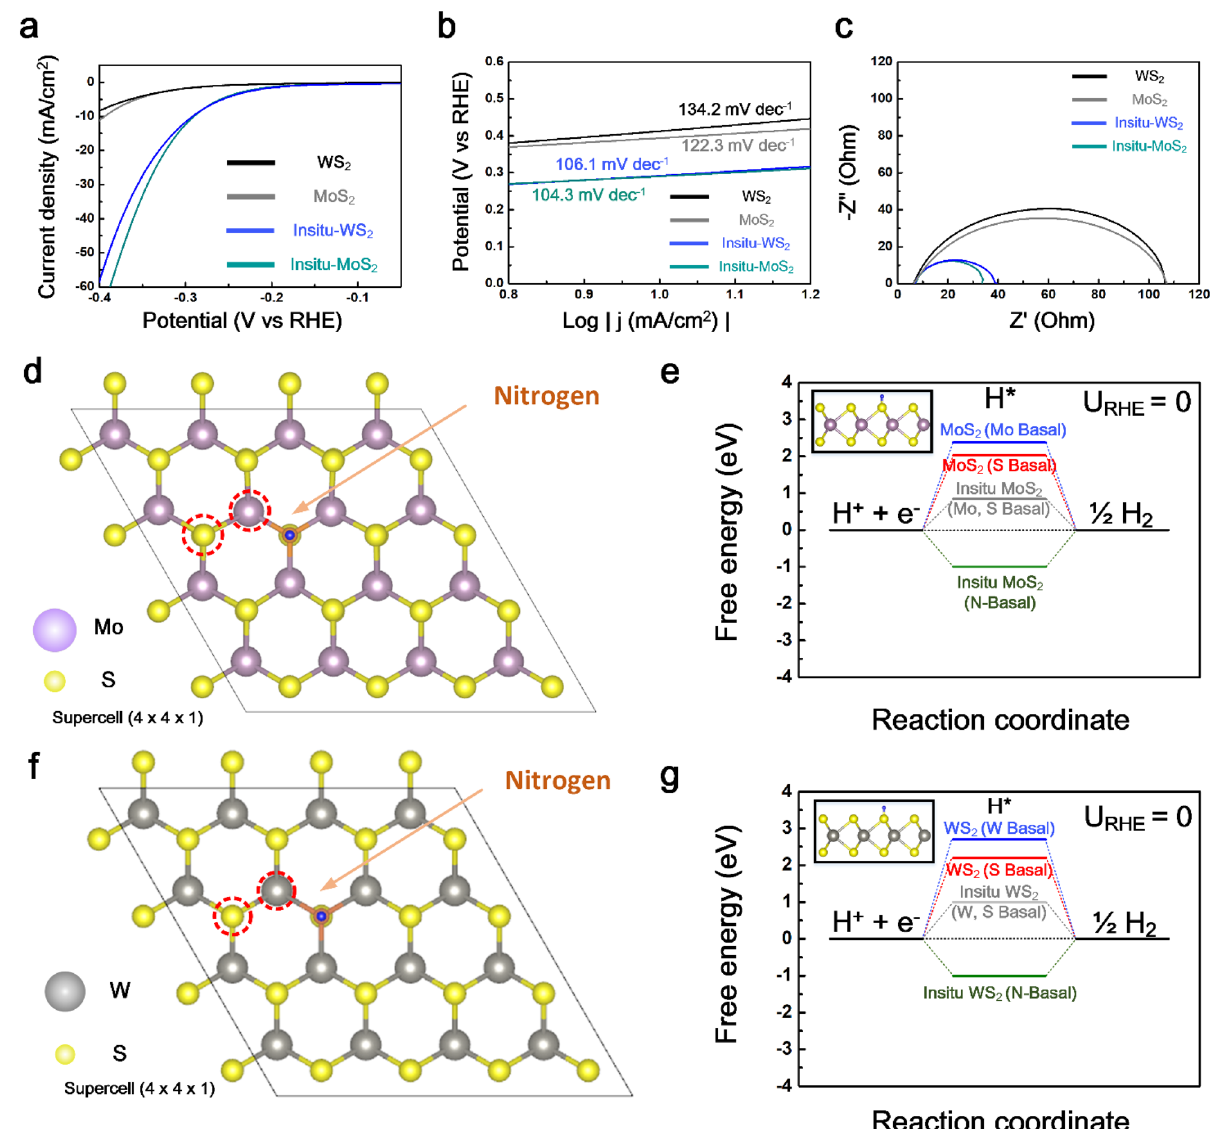
Figure 4. ( a ) LSV curves, ( b ) Tafel plot, and ( c ) EIS for pristine TMD and N doped TMD, respectively, with a scan rate of 5 mVs −1 ( d ) A 4 × 4 × 1 in situ-MoS 2 supercell used for the calculations. ( e ) Hydrogen Gibbs free energy profile for pristine MoS 2 and in situ-MoS 2 . ( f ) A 4 × 4 × 1 in situ-WS 2 supercell used for the calculations. ( g ) Hydrogen Gibbs free energy profile for pristine WS 2 and in situ-WS 2 . The red circle indicates the position of an absorbed hydrogen